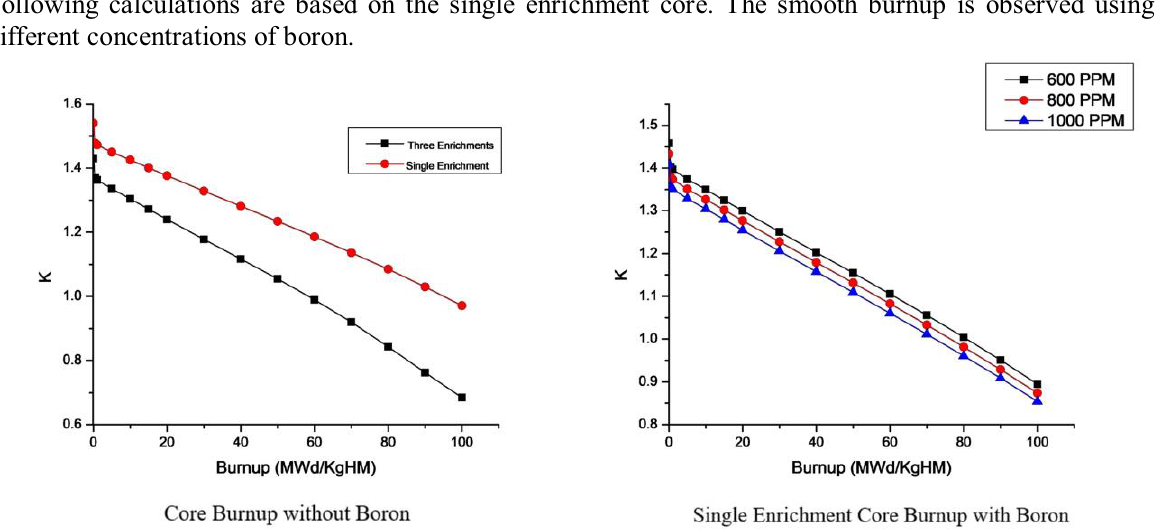
Figure 11. Full core burnup with Gd